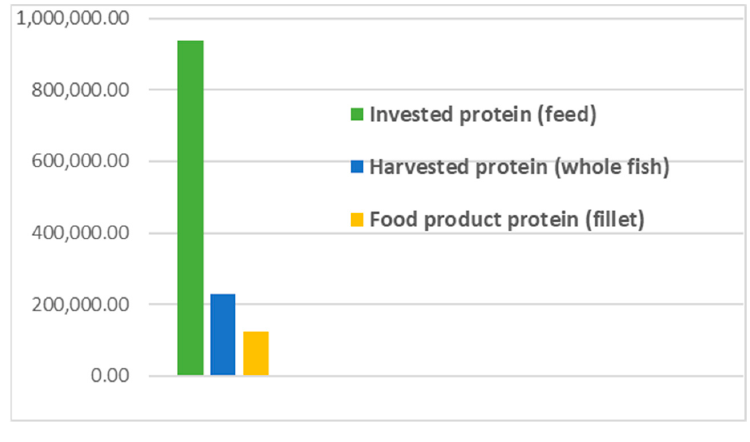
Figure 2. Quantity comparison. Foods 2020 , 9 , x